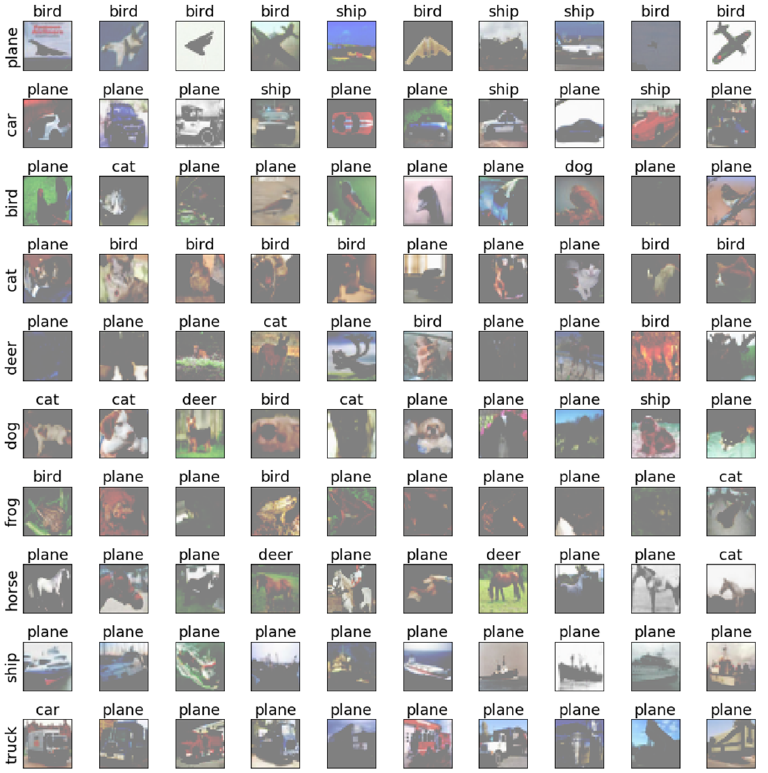
Figure 14. The adversarial examples of FGM for Cifar10 and ResNet18.